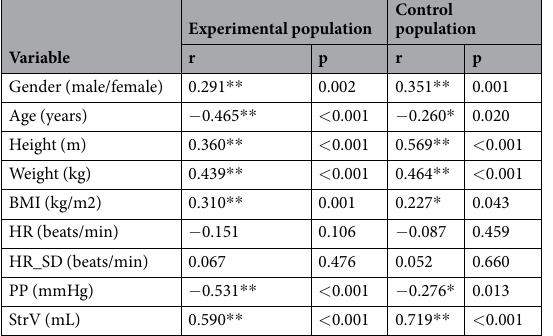
Table 3. The Pearson’s correlations of TAC with anthropometric measures values in hypertensive population and normal population. BMI, body mass index; HR, heart rate; TAC, total arterial compliance; PP, pulse pressure; StrV, stroke volume. * p < 0.05; ** P < 0.01.